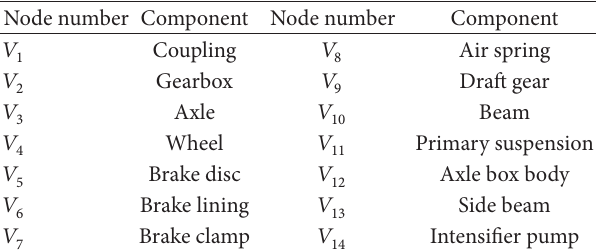
Table 2: Components’ names and serial numbers of bogie subsys-